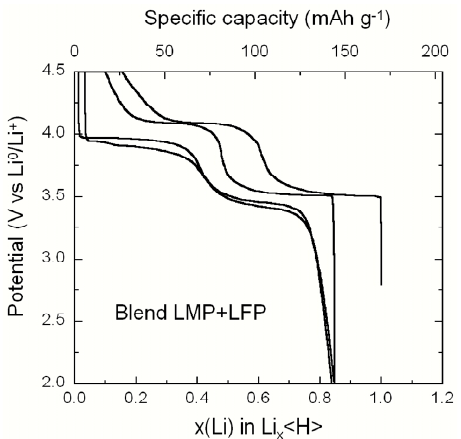
Figure 3. Charge-discharge profiles of Li coin cell with a LMP–LFP (66:33) blend positive electrode for the 1st and 2nd cycle. Electrochemical tests were carried out at C/12 in the potential range 2.0–4.5 V vs. Li 0 /Li + .